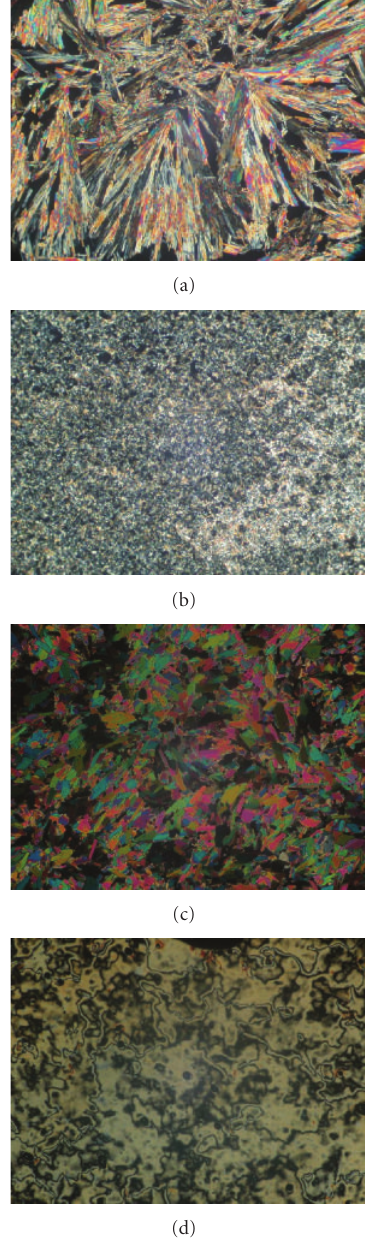
Figure 4: Polarized optical micrographs of 4-(decyloxy)benzoic acid taken during heating from the solid phase at (a) 25 ◦ C, (b) 91.4 ◦ C, (c) 106.8 ◦ C, and (d) 135.2 ◦ C.